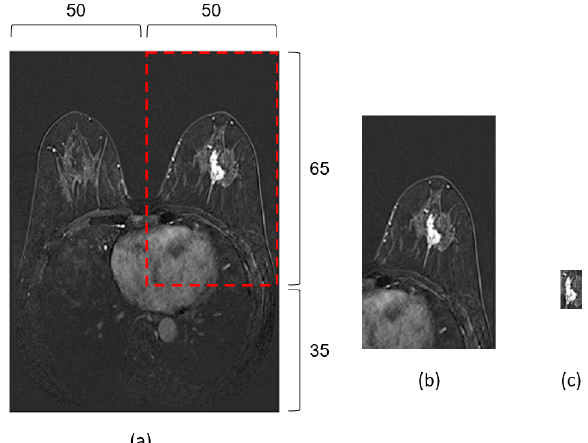
Figure 2. Examples of two types of data prepared for model training. The illustration of the cropping ratio ( a ). The first data is a quarter of image that contains the side of breast with tumor ( b ). The second data is an image cropped with the smallest tumor bounding box ( c